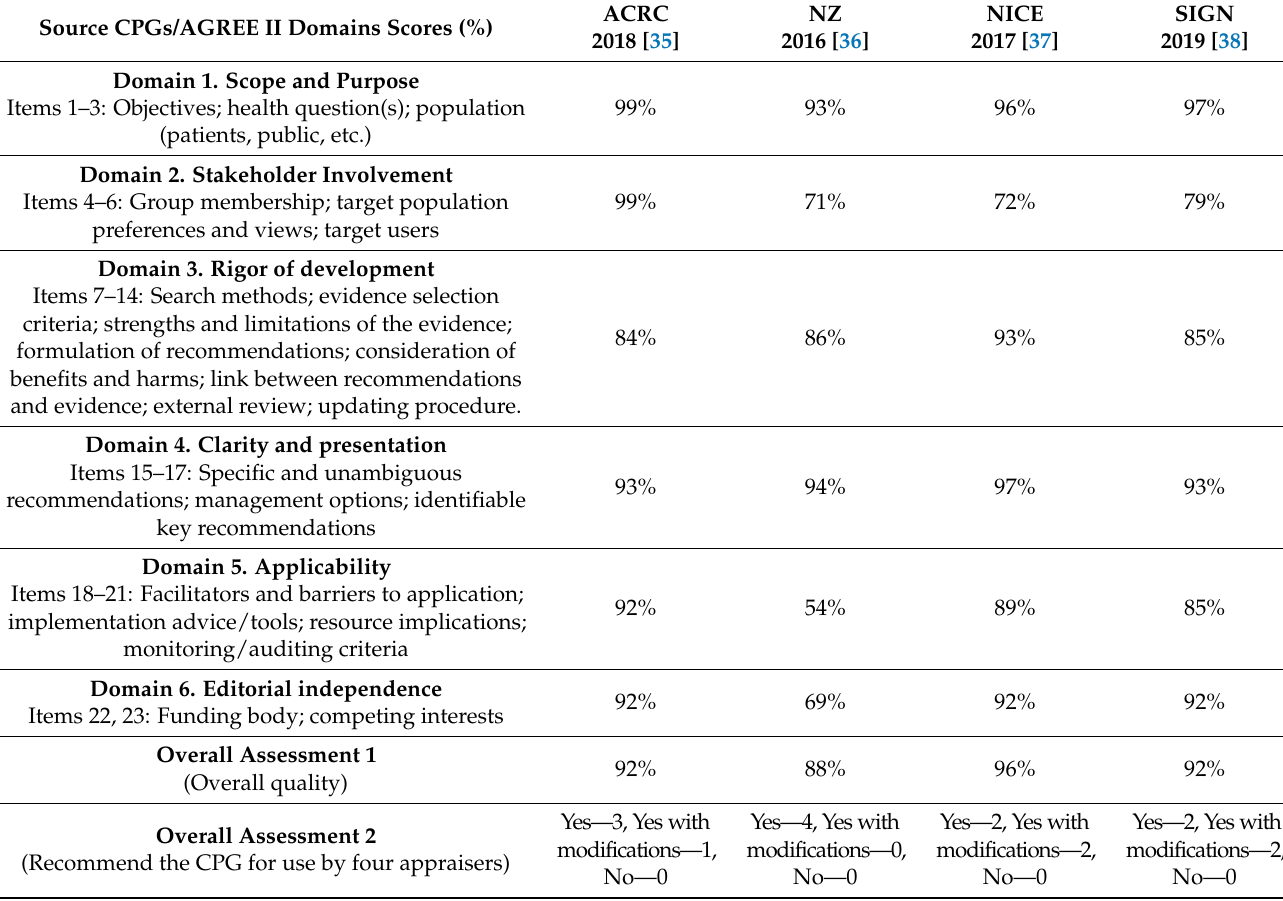
Table 2. AGREE II assessment results and domain scores for the four included CPGs